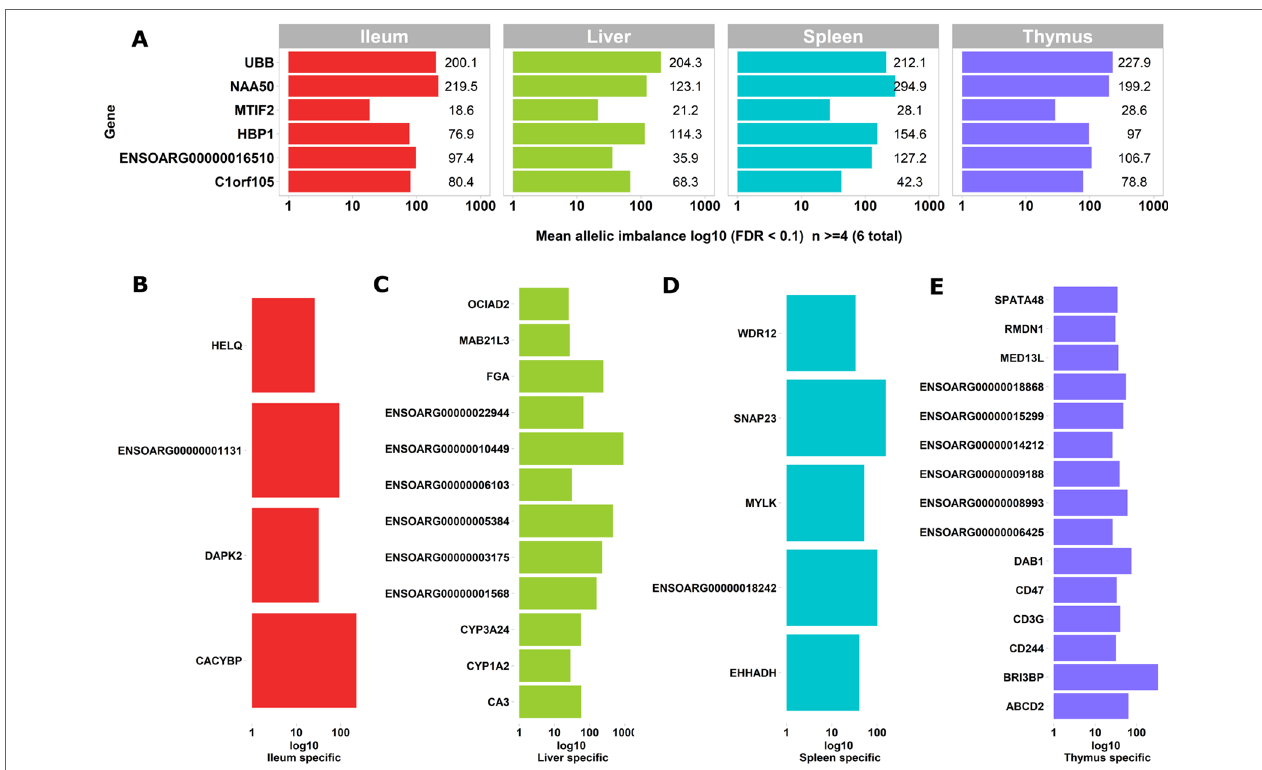
FIGURE 4 | Genes exhibiting static ASE shared across tissues from all six sheep. The x axis represents the mean allelic imbalance (averaged static ASE across sheep in each tissue). (A) Genes shared by four tissues with significant (false discovery rate [FDR], < 0.1) static ASE. (B) ASE genes private to Ileum. (C) Private to liver. (D) Private to spleen. (E) Private to